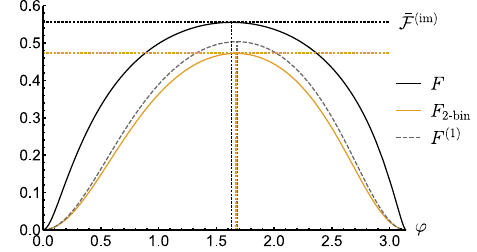
Fig. 2 | Computing FI for sensing phase θ with measurements experiencing Poissoniannoise. TheFIsarepresentedasafunctionoftherelativemeasurement- basis angle, φ = θ + ϕ , whose changes are equivalent to varying the input-state angle, ϕ , and/or the estimated phase, θ (we set λ ∣ 1 i = λ ∣ 0 i =0 : 65 and λ ∣ 0 i =27 76 ). The exact F (solidblack)isnumericallyapproximatedbysummingover x ≤ 100inEq.(9), while F 2-bin (solid orange) accounts for the binning method in Eq. (11) with the choice of the binning boundary x * furtheroptimised over.Wealso plot F (1) (dashed grey), the FI approximated with using just the fi rst two moments of the observed probabilitydistribution.Theverticaldottedlinesindicatethe(optimal) φ ateachof therespectivequantitiesismaximised.Notethatwhenthemeasurementisperfect, (cid:2) F ½ U θ (cid:2) is unity, and is for all choices of the angle φ (not shown). The horizontal dottedlinesdepictthe(numericallyapproximated)valuesofEq.(8), (cid:2) F ð im Þ = γ M ,for respective cases of the exact F and its two-binned